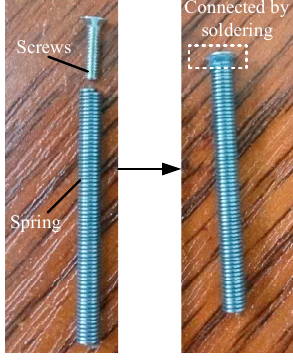
Figure 13. The composition of the pin.